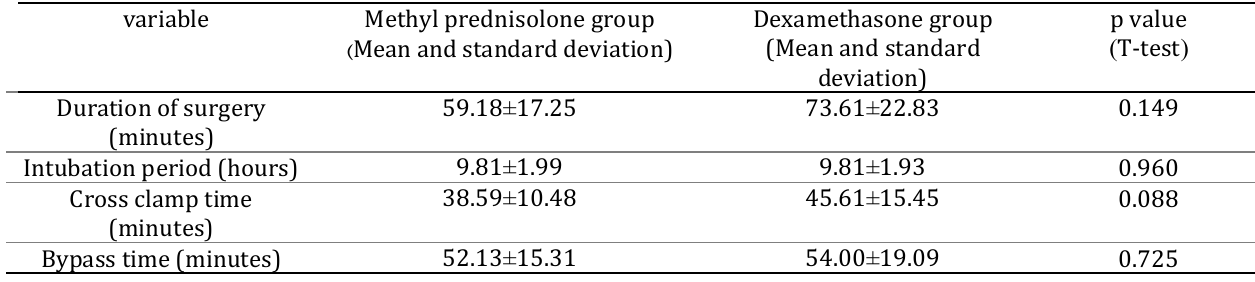
Table 2: Evaluation of delirium after surgery by group